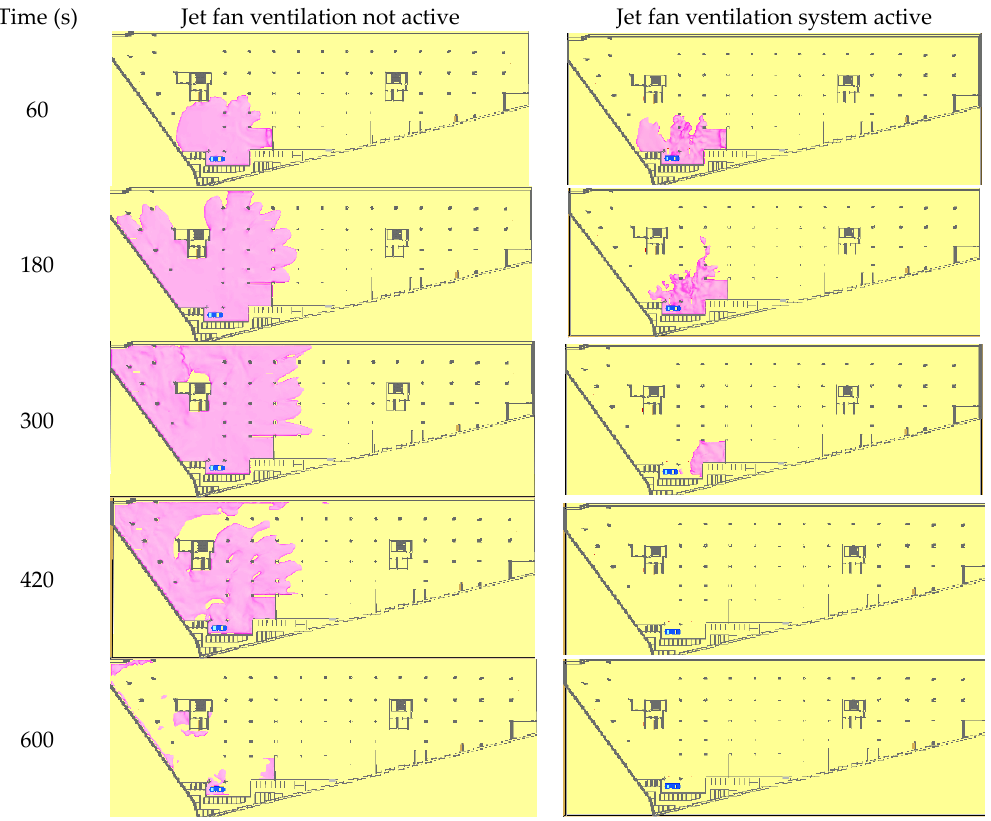
Figure 17. The range of the LPG flammable gas cloud in the seconds following the gas release.